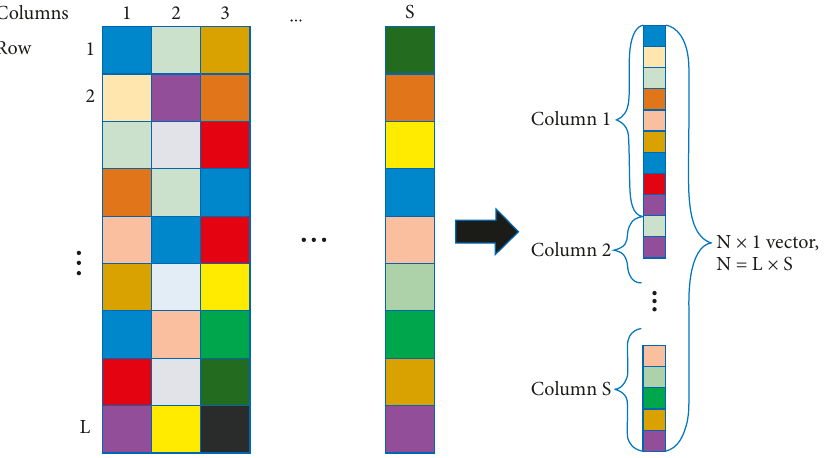
Figure 2: Illustration of converting an image into vector.